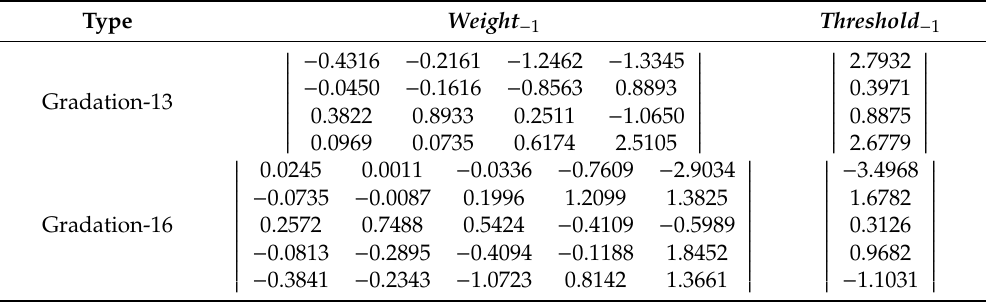
Table 12. The parameters from the input layer to hidden layer for Gradation-13 and Gradation-16. Type